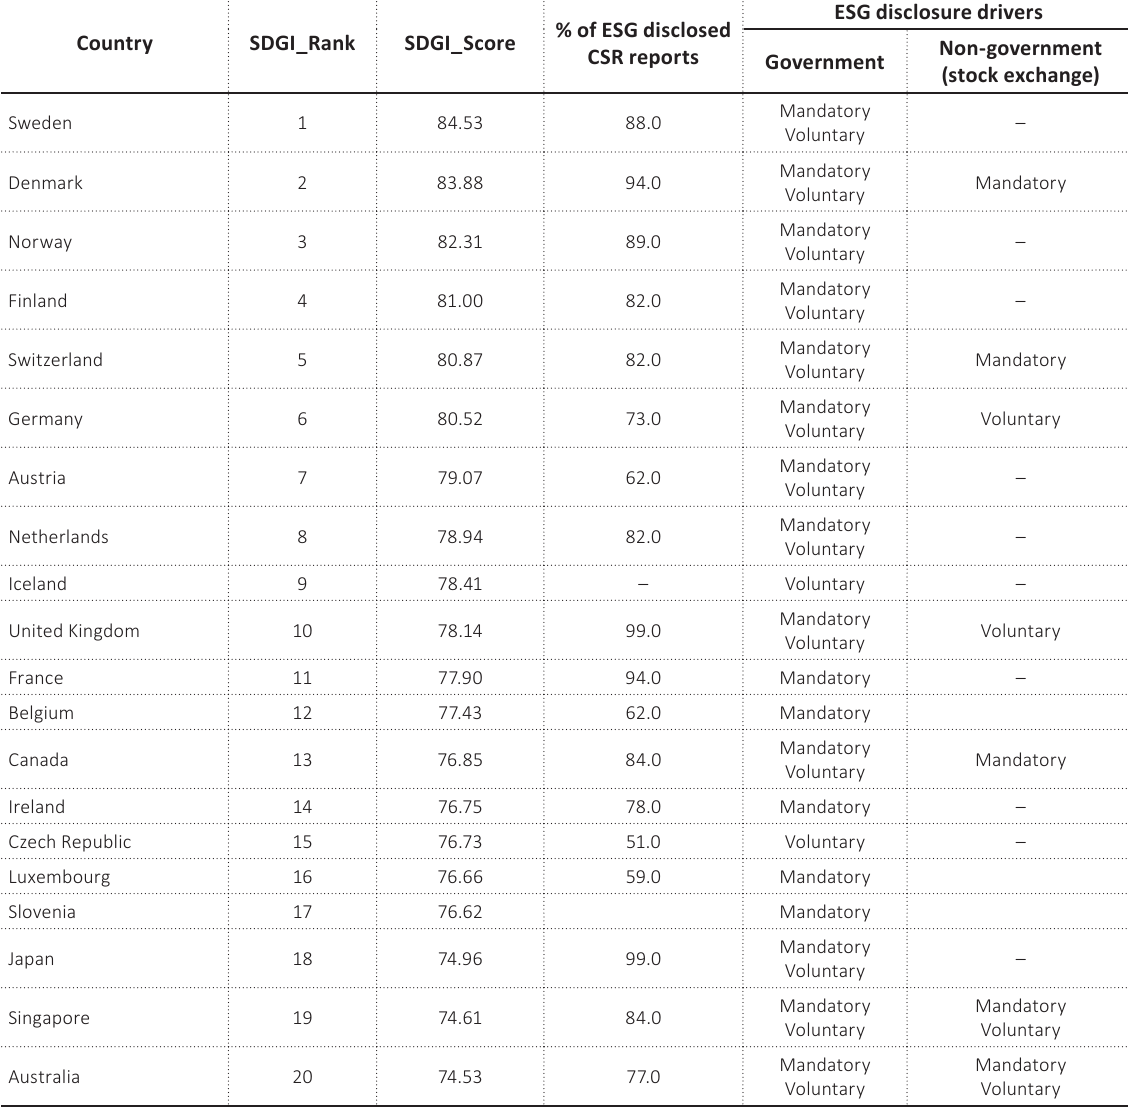
Table 2. Countries with the biggest progress in achieving SDGs and their share of ESG disclosure